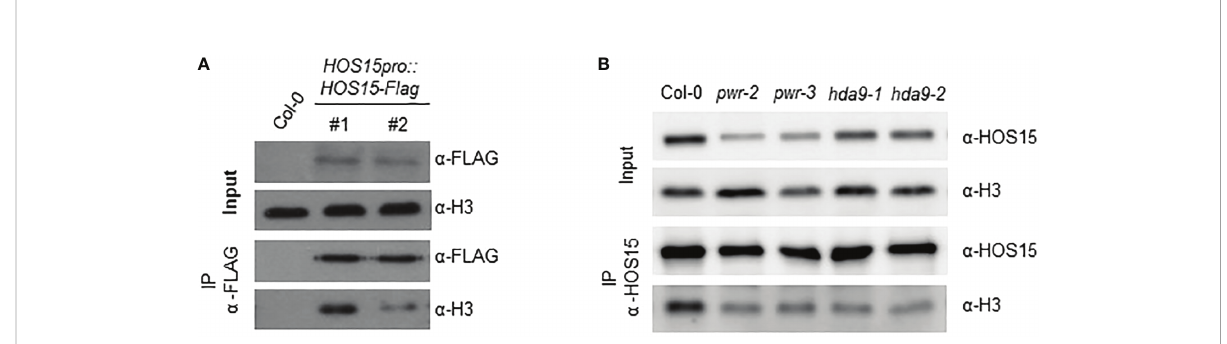
FIGURE 4 Interaction of HOS15 with histone H3. (A) Co-IP assay using two-week-old Arabidopsis Col-0 and HOS15pro:HOS15-Flag/hos15-2 complementation lines. Protein extracts (Input) were immunoprecipitated with anti-FLAG antibody and immunoblotted with anti-FLAG and anti-H3 antibodies (B) Co-IP assay using two-week-old Arabidopsis Col-0 hos15-2 , hda9 and pwr mutant plants. Protein extracts (Input) were immunoprecipitated with anti- HOS15 antibody and immunoblotted with anti-HOS15 and anti-H3 antibodies.